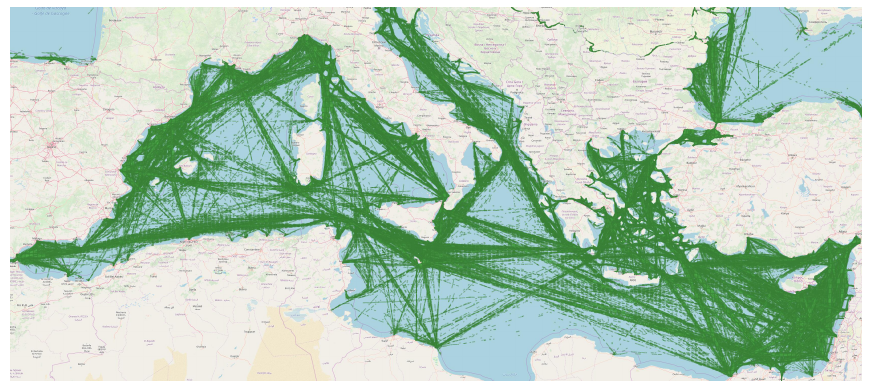
Figure 2. The final Maritime route